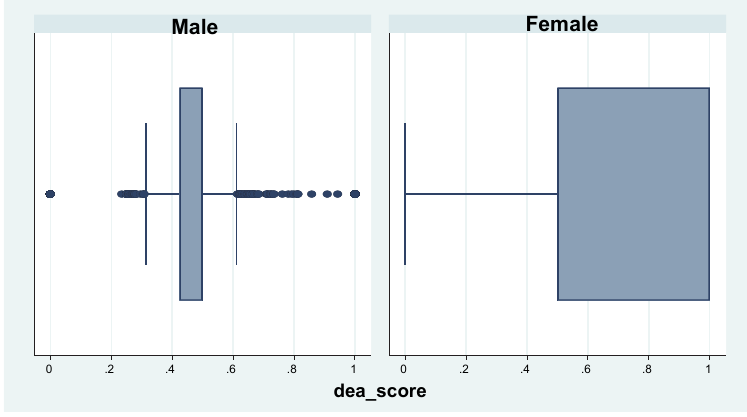
Fig. 2. Technical efficiency by gender of the farm heads